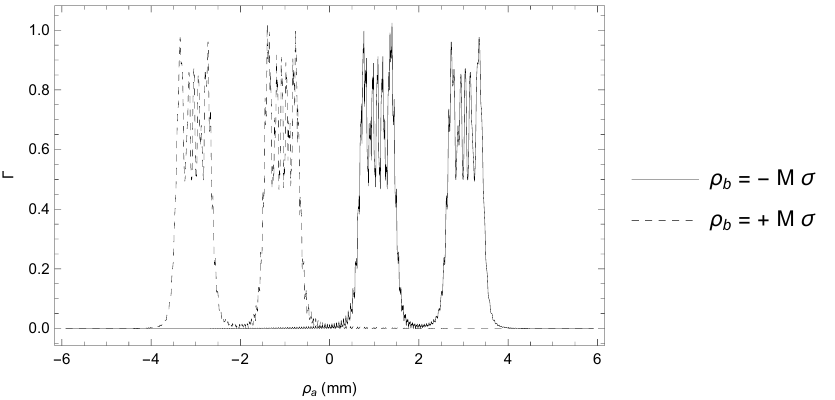
Figure 5. Observation of a double slit of width a = 0.2mm and center-to-center distance 2 a from two different points of view. Here, the setting is one-dimensional, with the same parameters as the setup described in Section 3. The coherent ghost images of Equation (10) enable us to change the point of view on any out-of-focus plane by selecting the point ρ b on the sensor S b , corresponding to a source point ρ s = − ρ b / M . In this case, the axis of the double slit coincides with the optical axis, and the chosen points on S b are ρ b = − M σ (solid line, on the right) and ρ b = + M σ (dashed line, on the